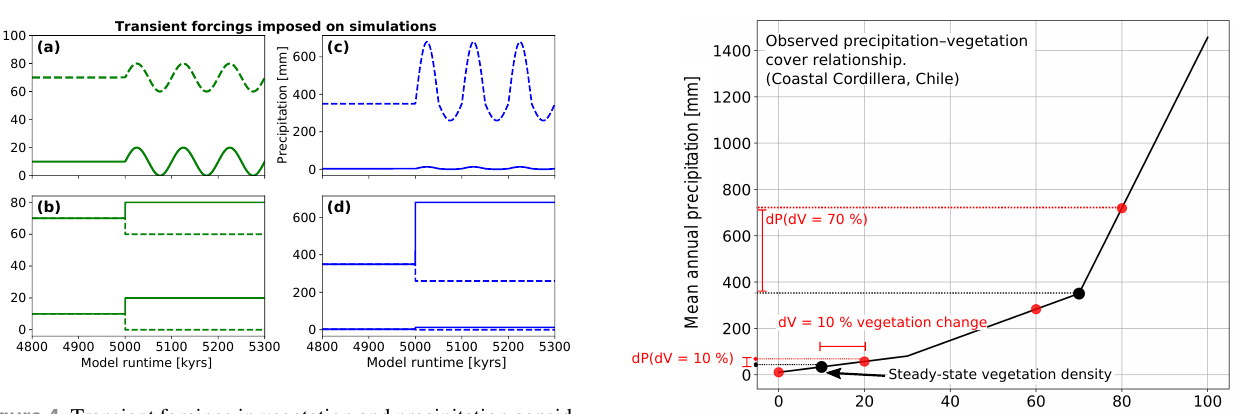
Figure 4. Transient forcings in vegetation and precipitation consid- ered in model experiments. Simulations were run for 15Myr prior to the runtime shown in the figure. All transients imposed started at a runtime of 5Myr. (a) Variations in vegetation cover imposed in the oscillating experiment conditions for an initial vegetation cover of 10 and 70%. Oscillations have a 10% amplitude and a 100kyr pe- riodicity. (b) 10% positive and negative step changes in vegetation cover imposed on simulations with 10% and 70% initial vegeta- tion cover. (c) Oscillating mean annual precipitation. Positive and negative amplitudes of oscillation resemble the magnitude of pre- cipitation change extracted from the vegetation cover–rainfall rela- tionship from satellite data (Fig. 5). (d) Positive and negative step changes in mean annual precipitation. The initial precipitation was based on values extracted from the WorldClim climate dataset for respective focus areas.